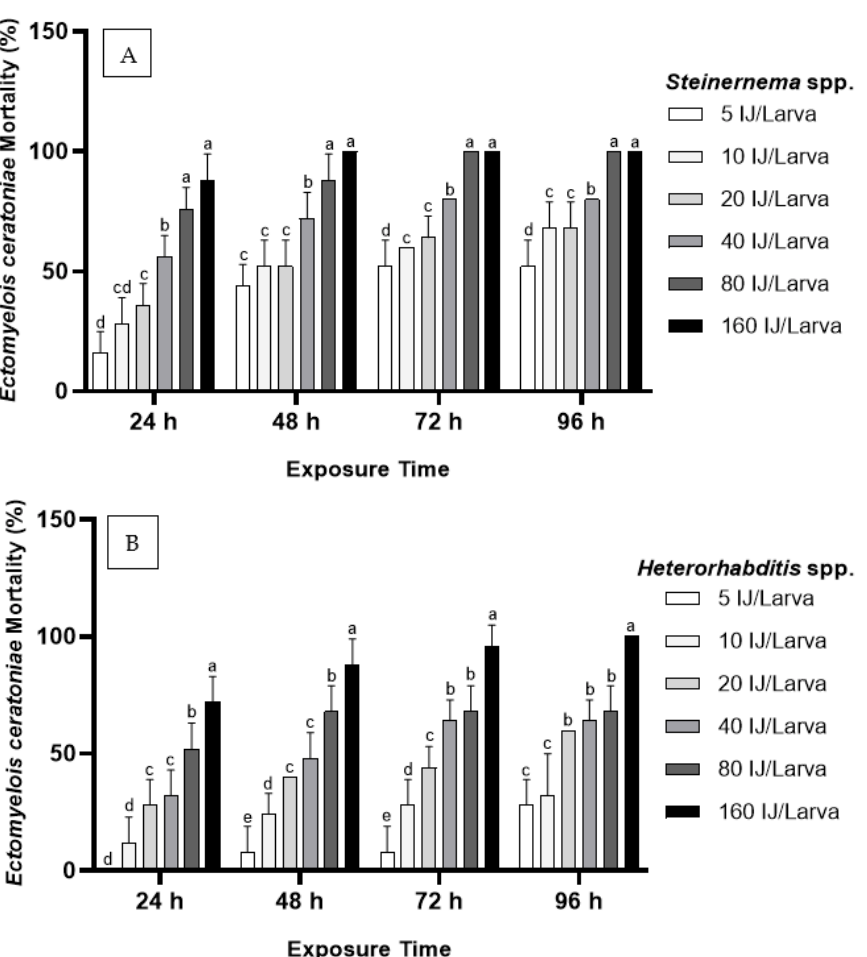
Figure 3. Mortality percentage (mean ± SE) of the carob moth, Ectomyelois ceratoniae , exposed to different levels (5, 10, 20, 40, 80, and 160 IJ/Larva) of Steinernema spp. ( A ) and Heterorhabditis spp. ( B ) at different exposure times (24, 48, 72 and 96 h). Bars annotated with the same letter are not significantly different ( p < 0.05, based on Duncan test). Table 3. Pathogenicity of two EPNs against the pomegranate butterfly, Virachola livia